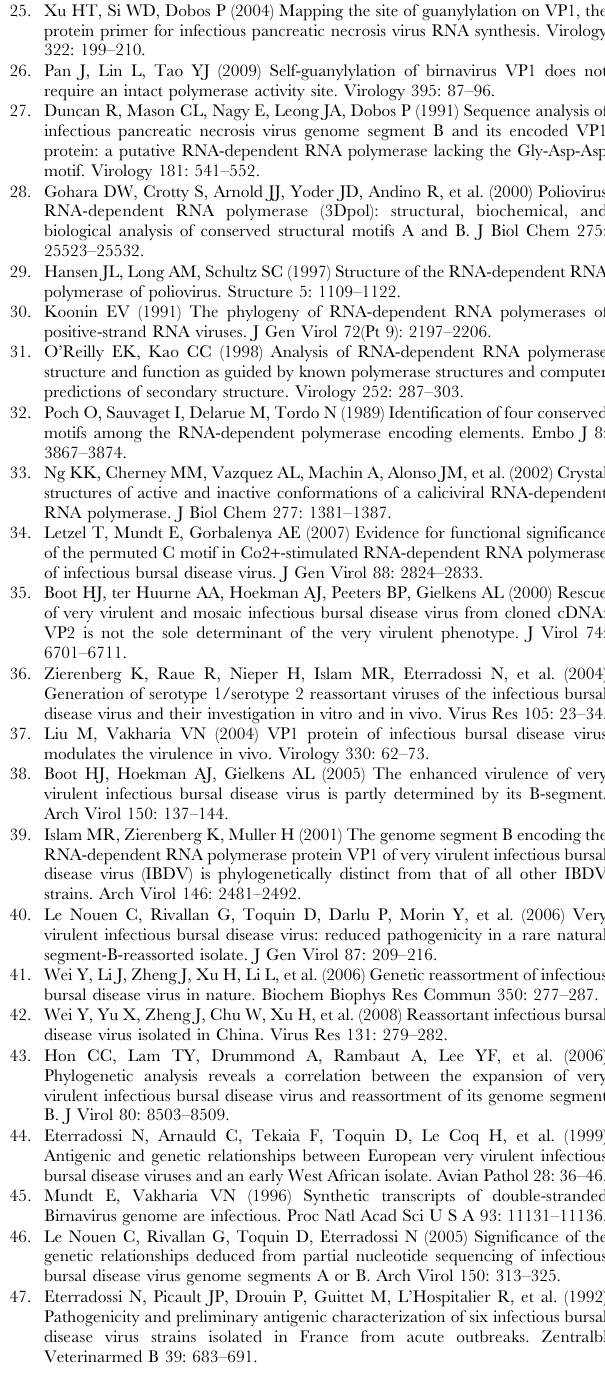
Table S3 Summarized protocol of the three animal experiments. The three animal experiments were designed to: i) compare the pathogenicity of 88180 with mc88180, ii) compare the pathogenicity of mc88180, mcCu-1 and reassortant viruses derived thereof and iii) compare the pathogenicity of mosaic segment-B derived